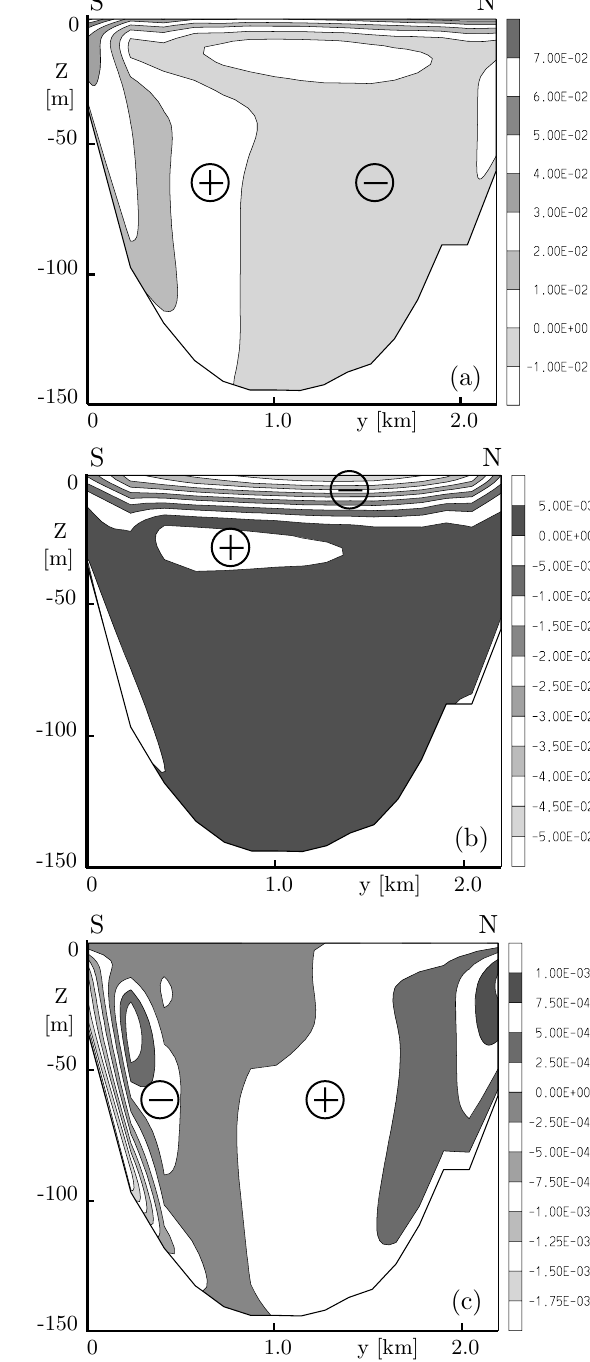
Fig. 17. Isotachs of the two horizontal and vertical velocity compo- nents (a) u , ( b )v and (c) w in a cross-section of the middle of the 2 s − 1 . v = 0 . 02m ¨Uberlinger See in steady state, subject to constant wind from 305 ◦ NW approximately in the longitudinal direction (perpendicular to the plane of the graphs upwards) computed with the vertical eddy viscosity ν v = 0 . 005m 2 s − 1